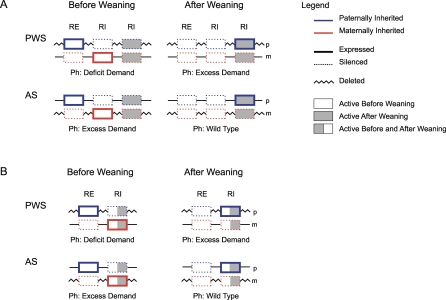
Composition of PWS/AS ClusterEach figure represents the composition in terms of type of gene (resource enhancer or resource inhibitor) and window of expression of each gene (either before weaning, or after weaning, or before and after weaning). Within each figure, I represent the genotype of a patient with PWS and AS. I use a zigzag line to represent a deleted strand. Underneath each scheme, I note the predicted phenotype. I assume that before weaning, the maternal contribution of resources (relative to the paternal one) is greater than
σ̂#x0963;
σ̂#x0302; but after weaning, the relative maternal contribution of resources is less than
σ̂. I present two alternative compositions: (A) corresponds to the possibility that genes are expressed in each period (before or after weaning) but not across periods (before and after weaning). (B) corresponds to the possibility that genes are expressed across periods.